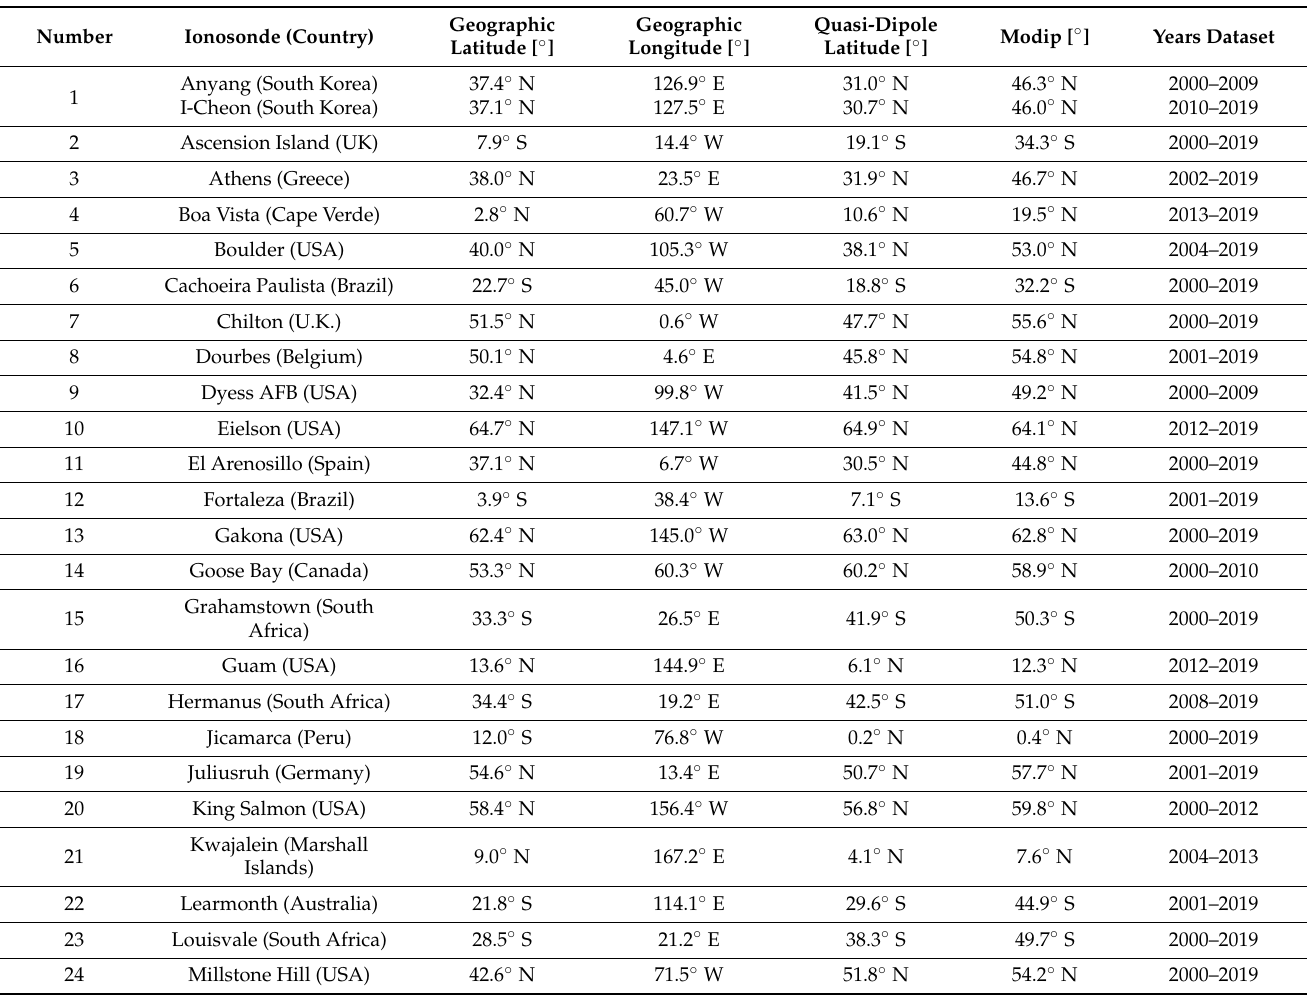
Table 1. The ionosonde stations considered for validation along with the corresponding geographic coordinates, QD magnetic latitude, modip, and time coverage of the